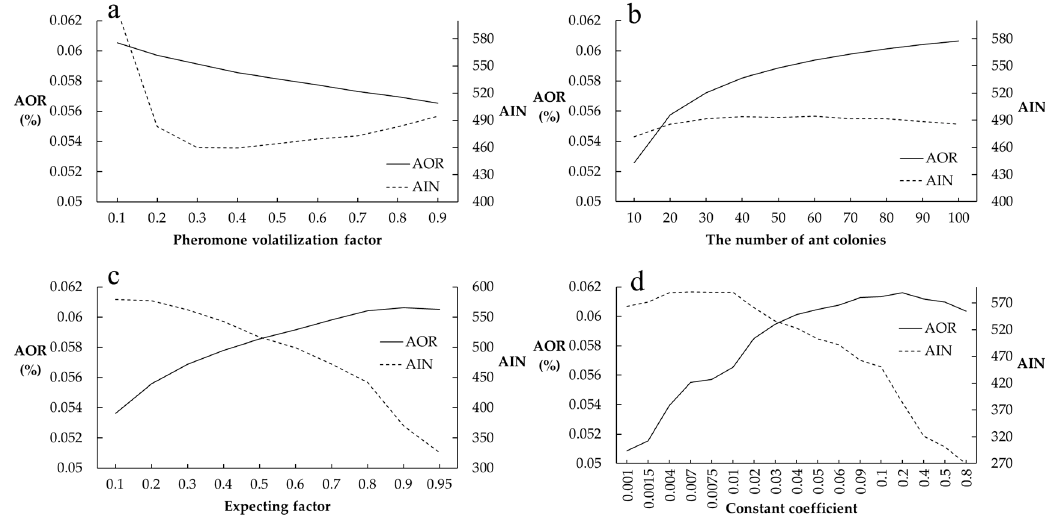
Figure 4. Relationship between parameter setting and average optimization rate (AOR) and average iteration number (AIN): ( a ) pheromone volatilization factor; ( b ) the number of ants; ( c ) expecting factor; ( d ) constant coefficient.